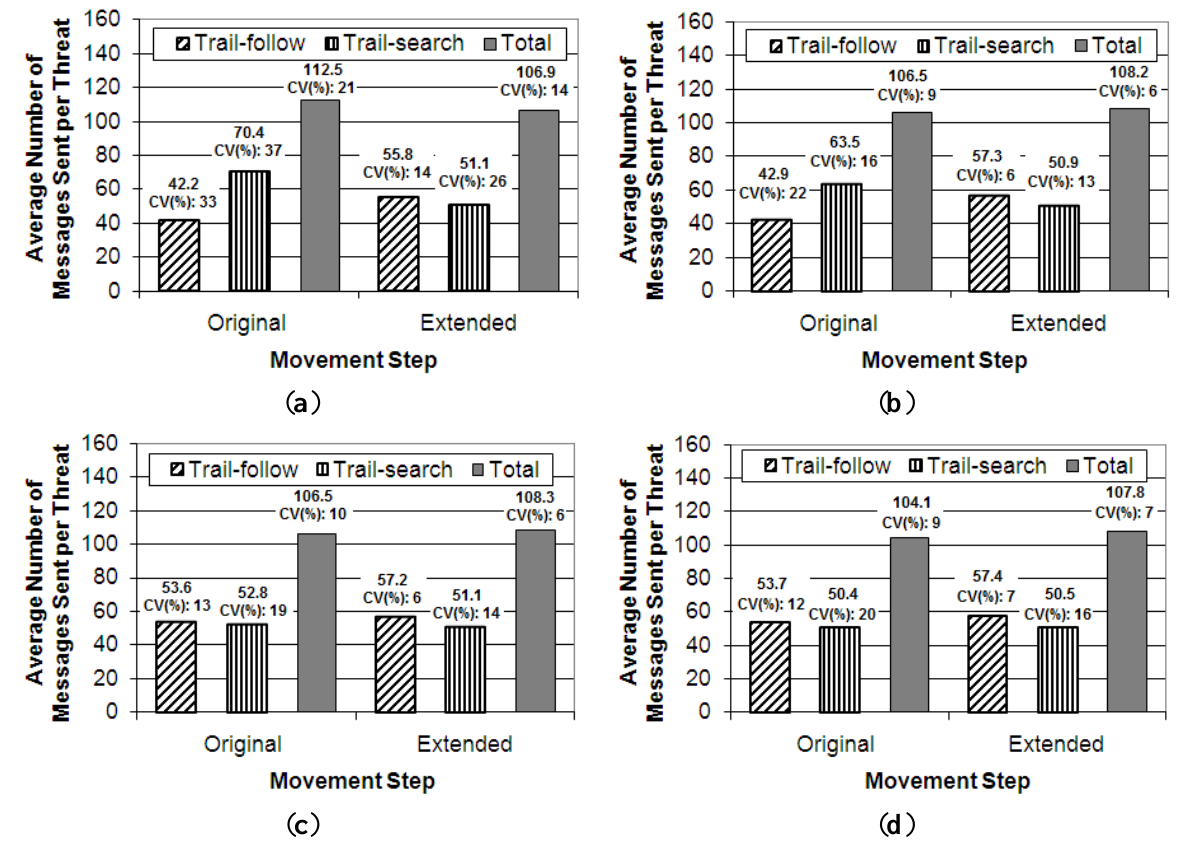
Figure 15. Results of the cost metric due to the trail-search and trail-follow mechanisms and to the total (trail-search plus trail-follow) for the simulations with 2 Unmanned Aerial Vehicles for both original and extended movement step: ( a ) one threat; ( b ) three threats; ( c ) five threats; ( d ) seven